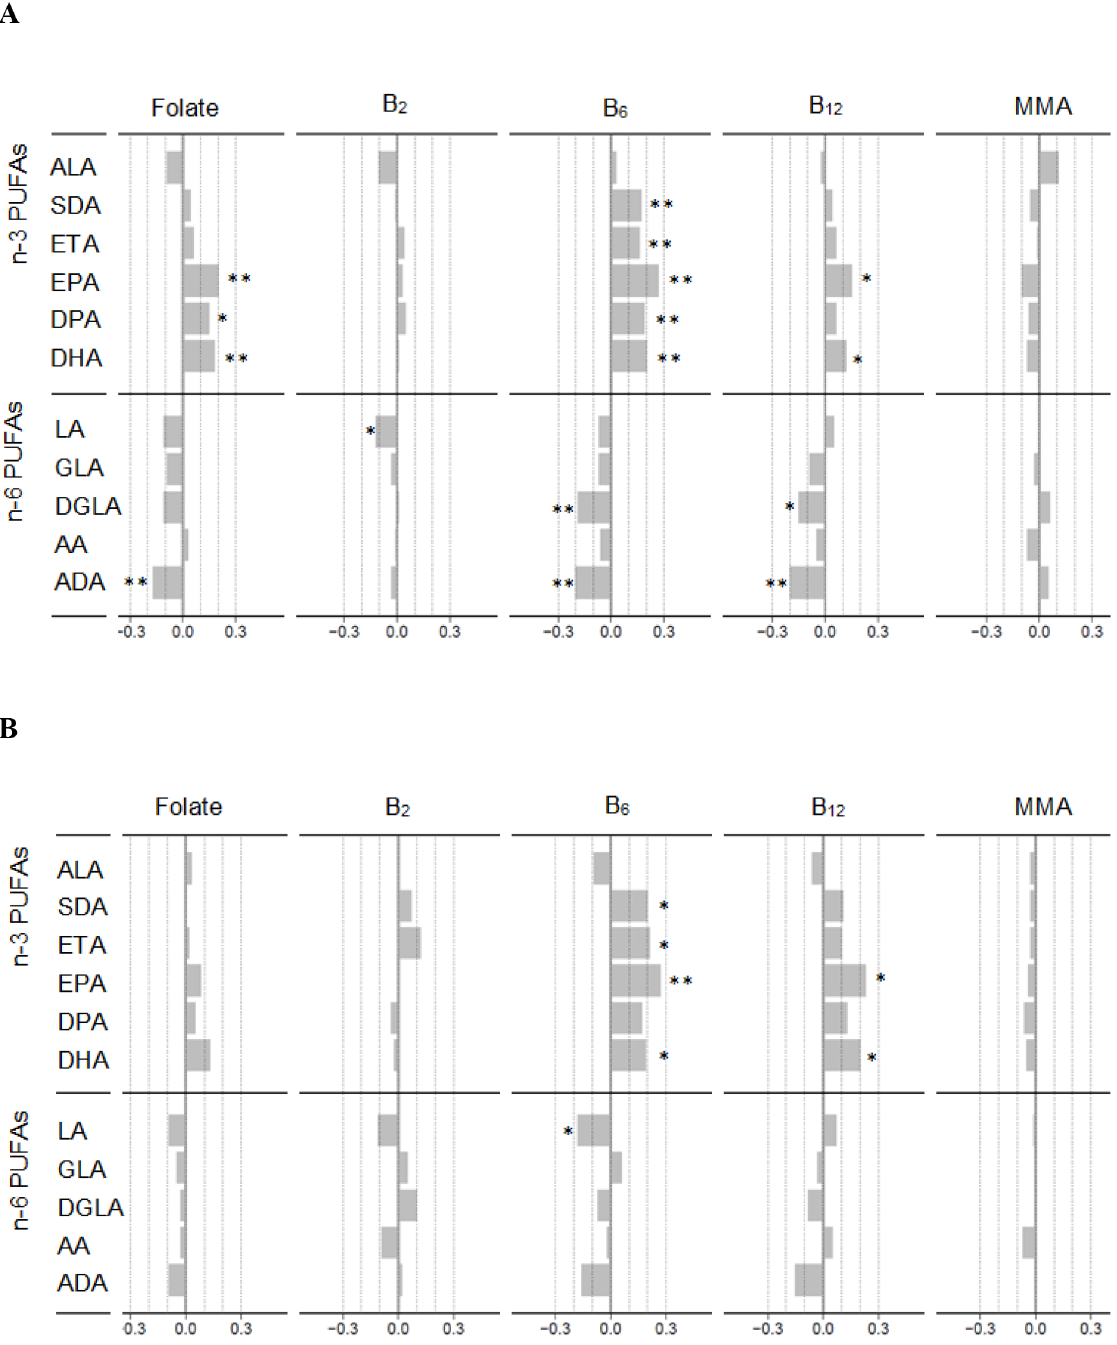
Fig 1. The relationship between circulating B-vitamins and serum n-3 and n-6 PUFAs in non-smokers and smokers. Spearman ’ s rho (r) of ranked values of circulating B-vitamins folate, B 2 , B 6 , B 12 and MMA with serum n-3 and n-6 PUFAs in non-smokers (n = 480) (A) and smokers (n = 215) (B) who completed the food frequency questionnaire. The models for n-3 PUFAs were adjusted for gender, age, effective statin dose and dietary intake of n-3 PUFAs (ALA, EPA, DPA and DHA) (g/d); The models for n-6 PUFAs were adjusted for gender, age, effective statin dose and dietary intake of n-6 PUFAs (LA and AA) (g/d). AA, arachidonic acid; ADA, Adrenic acid; ALA, alpha linolenic acid; B 2 , riboflavin; B 6 , pyridoxal 5 ’ -phosphate; B 12 , cobalamin; DGLA, dihomo- γ - linolenic acid; DPA, docosapentaenoic acid; ETA, eicosatetraeonic acid; GLA, γ -linolenic acid; LA, linoleic acid; MMA, methylmalonic acid; SDA, Stearidonic acid. * p < 0.01, ** p < 0.001.